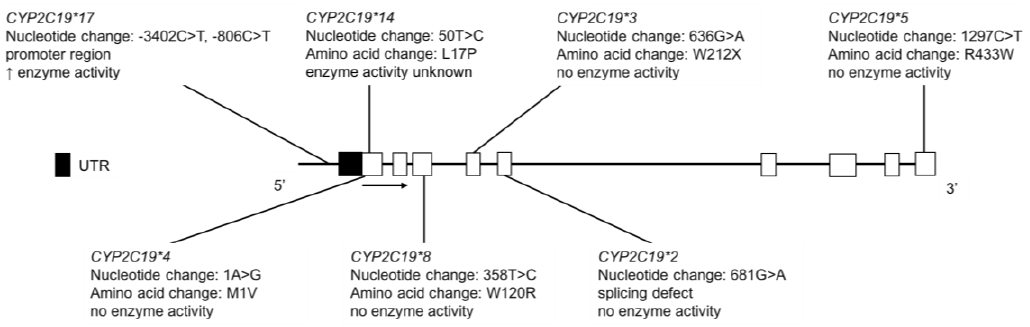
Figure 8. The human CYP2C19 gene and SNVs genotyped for in AI, FN, Inuit and Amerindian populations. Open boxes represent exons, lines represent introns and shaded boxes represent UTR. Table 8. Comparison of CYP2C19 allele frequencies in Indigenous North American populations to global populations from the 1000 Genomes Project [20]. For alleles defined by multiple variants, the frequencies reported in Zhou et al. using LDLink software [81] were used. N represents the number of alleles. Not shown in the table are CYP2C19*5 (rs56337013) and *CYP2C19*14 (rs55752064), as they were not found in any Amerindian populations and not genotyped for in Indigenous peoples of Canada or